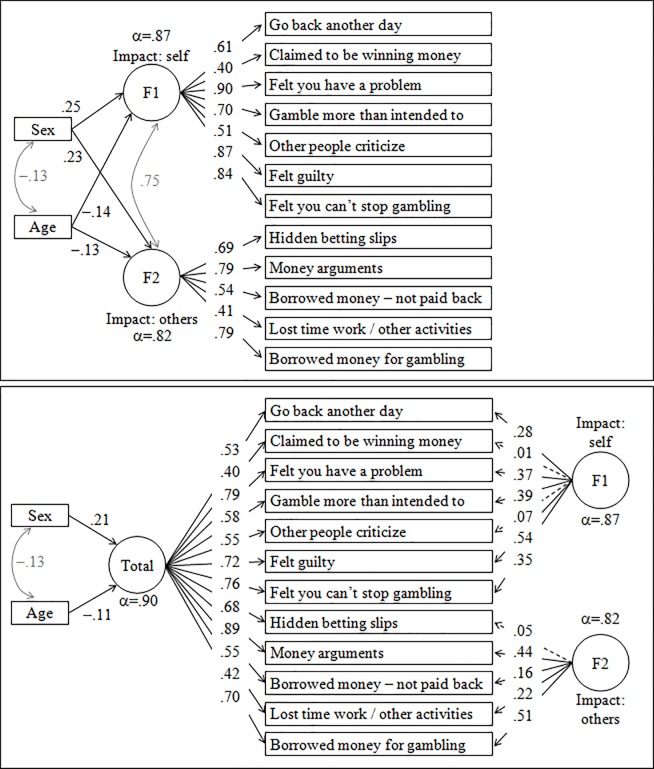
Path-diagrams with the standardized coefficients for three bifactor model in the study.Note. Continuous line: significant parameter. Dashed line: non-significant parameter. Grey color: covariance coefficients. α: Cronbach’s alpha.